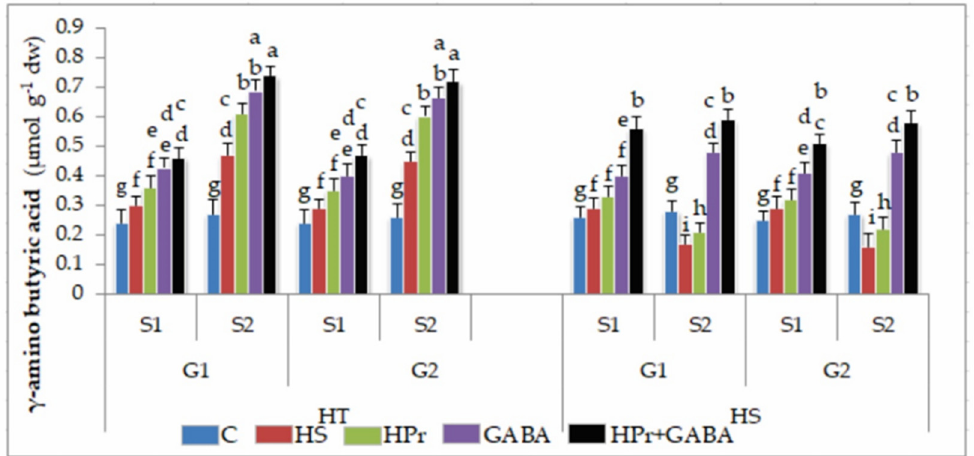
Figure 8. Effect of heat priming (HPr) and γ -amino butyric acid (GABA), applied individually or in combination (HPr+GABA) on endogenous GABA in heat-tolerant (G1: IG2507; G2: IG3263) and heat-sensitive (G1: IG2821; G2: IG2849) genotypes at stage 1 (S1) and stage 2 (S2) in heat-stressed (HS) lentil plants, compared to control (C). Vertical bars represent standard errors ( n = 3). Different small letters on the bars indicate significant differences from each other ( p < 0.05). LSD for interaction (genotypes × stages × treatments) ( p < 0.05): 0.038. dw = dry weight.